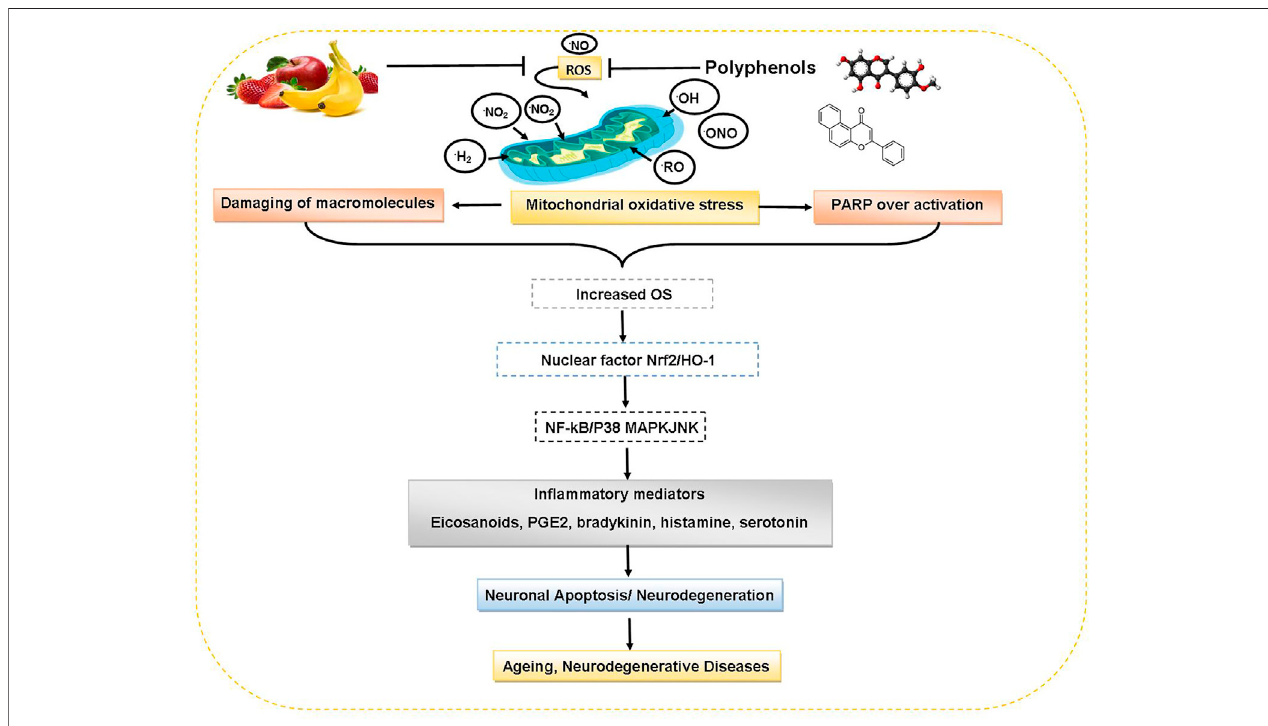
FIGURE 5 | Protective roles of dietary polyphenols against aging and neurodegenerative disorders. Abbreviations: Nrf 2: nuclear factor erythroid 2, HO-1: heme oxygenase-1, NF-kB: nuclear factor kappa-light-chain-enhancer of activated B cells, P38 MAPK: protein 38 mitogen-activated protein kinase, JNK: Jun N-terminal kinase, PGE2: prostaglandin